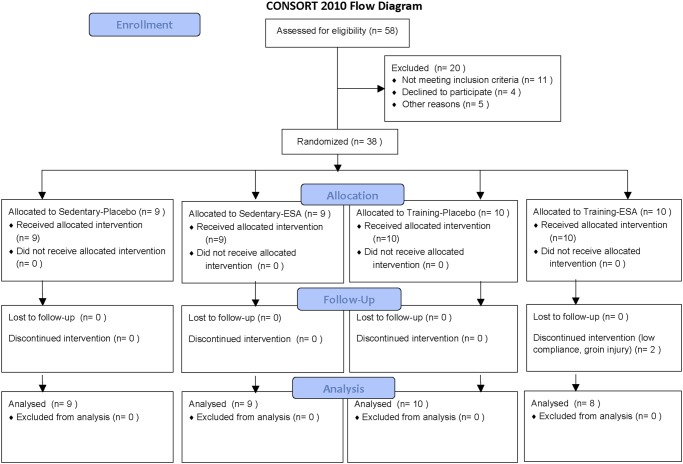
CONSORT flow diagram.